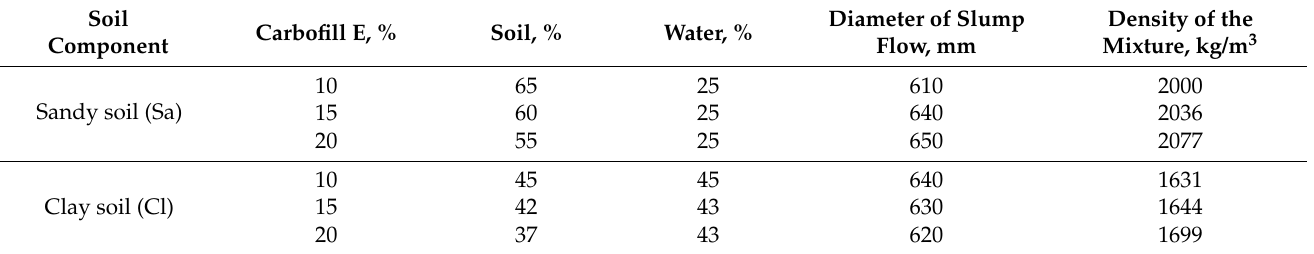
Table 3. Components used in the preparation of SCS mixtures and physical properties of the mixtures.